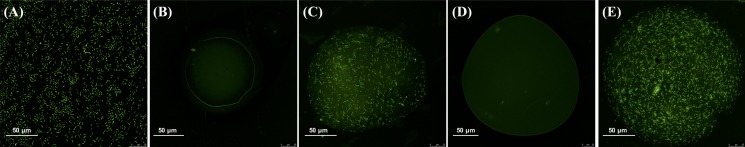
Confocal micrographs of panel (A)
Bifidobacterium longum, (B) alginate microcapsule without B. longum, (C) alginate microcapsule with B. longum, (D) chitosan-coated alginate microcapsule without B. longum, and (E) chitosan-coated alginate microcapsule with B. longum. All samples were stained with acridine orange fluorescent dye to enable DNA detection.